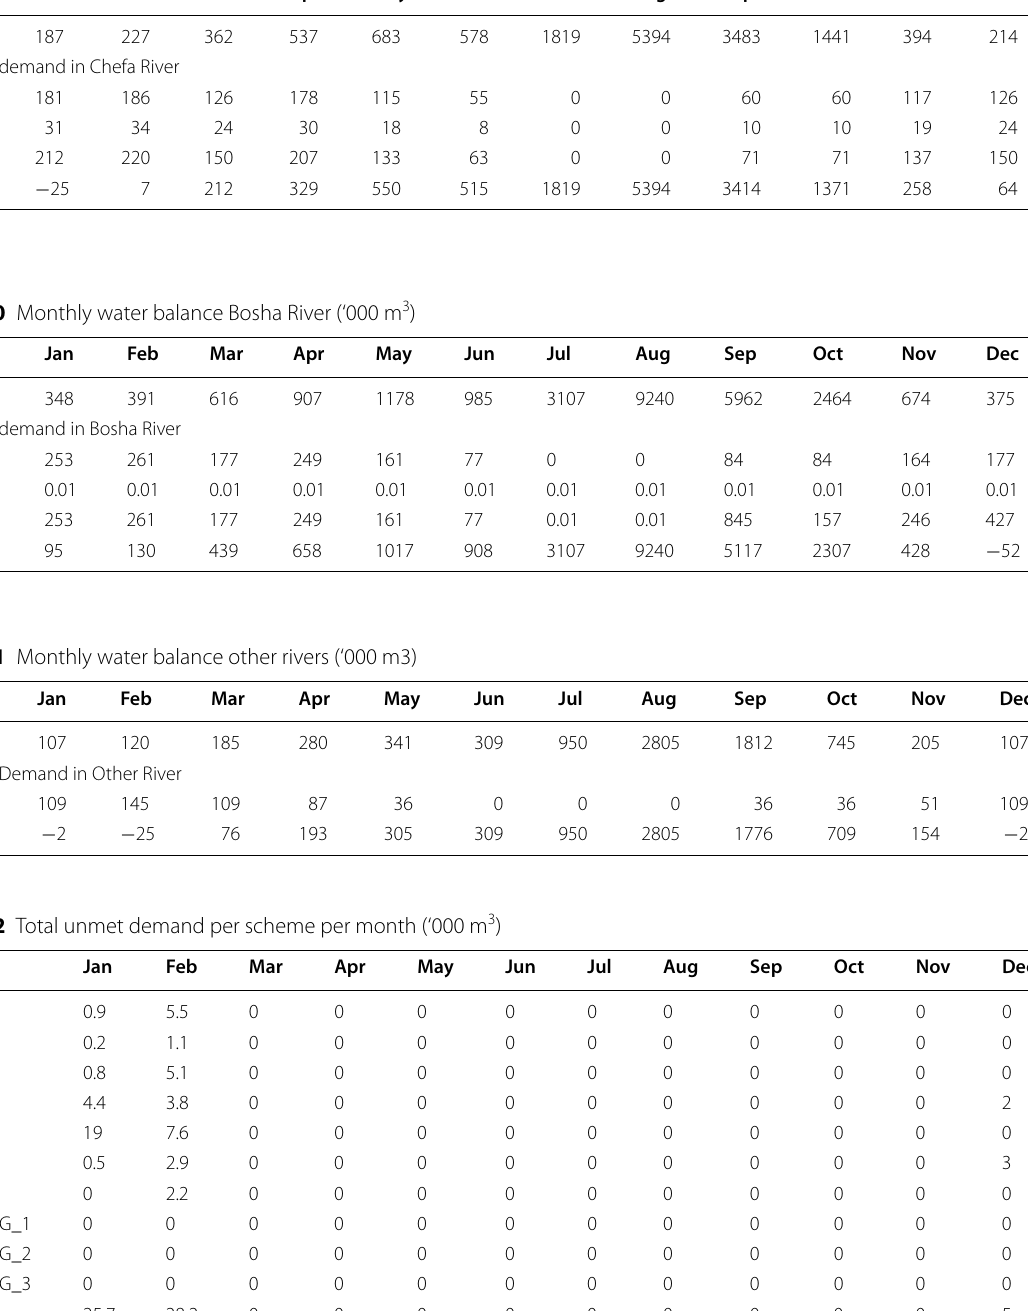
Table 9 Monthly water balance of Chefa River (‘000 m3) Jan